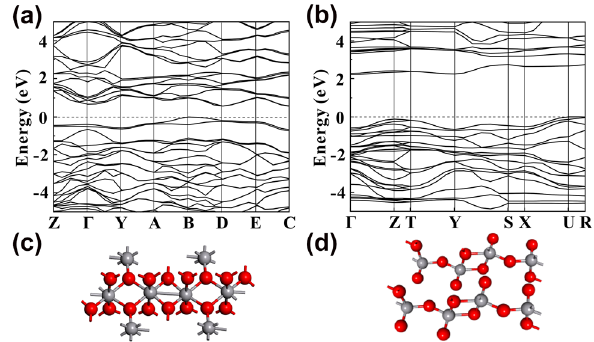
Figure 10: Energy band diagrams and the molecular structure. (a) Energy band diagram of VO 2 . (b) Energy band diagram of V 2 O 5 . (c) Molecular structure of VO 2 . (d) Molecular structure of V 2 O 5 .